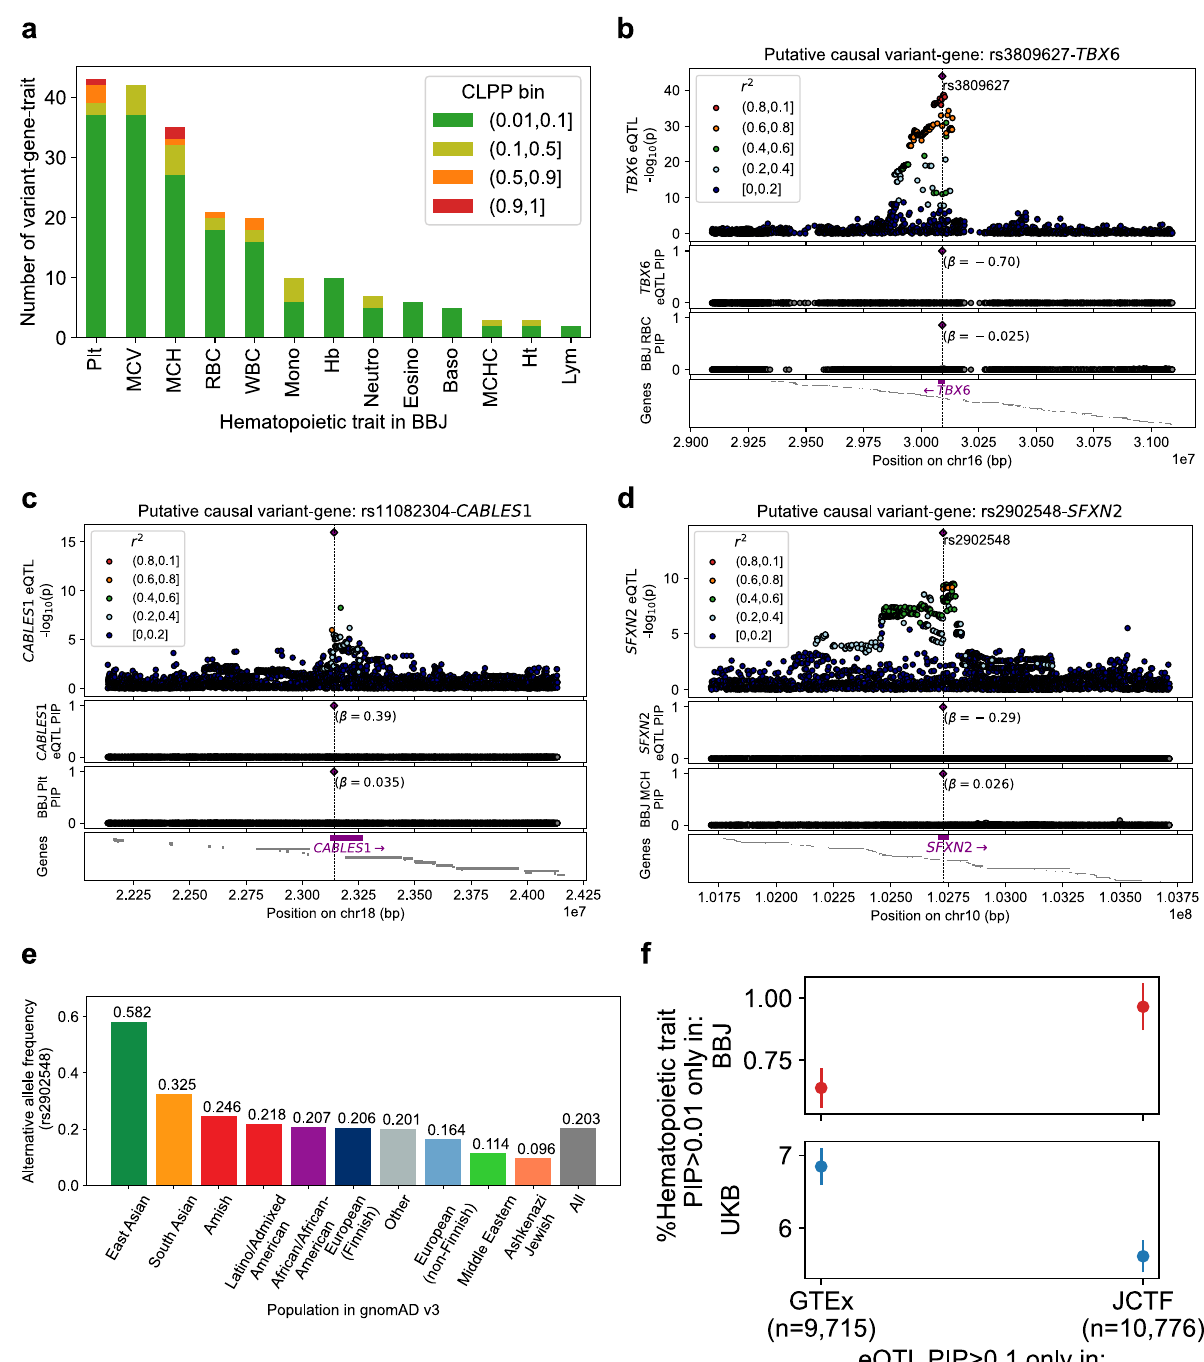
Fig. 4 | Colocalization of eQTLs with possible hematopoietic trait-causal var- iants suggested in biobank studies. a Number of variant-gene-trait pairs (y axis) with suggestive colocalization posterior probabilities (0.01<CLPP), for different hematopoietic traits (xaxis) inBiobank Japan(BBJ). b – d Association p value (top), eQTL PIP (second row) and BBJ trait PIP (third row) of the SNVs in ±1 Mb ( b , c ) or ±100kb( d )window,aswellasthelocationofthegenes(bottomrow).Theputative